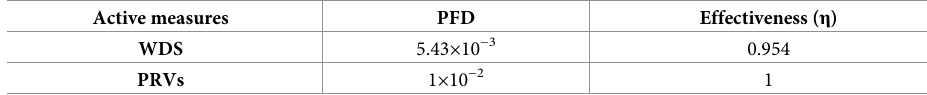
Table 21. PFD and effectiveness values of active measures [57].